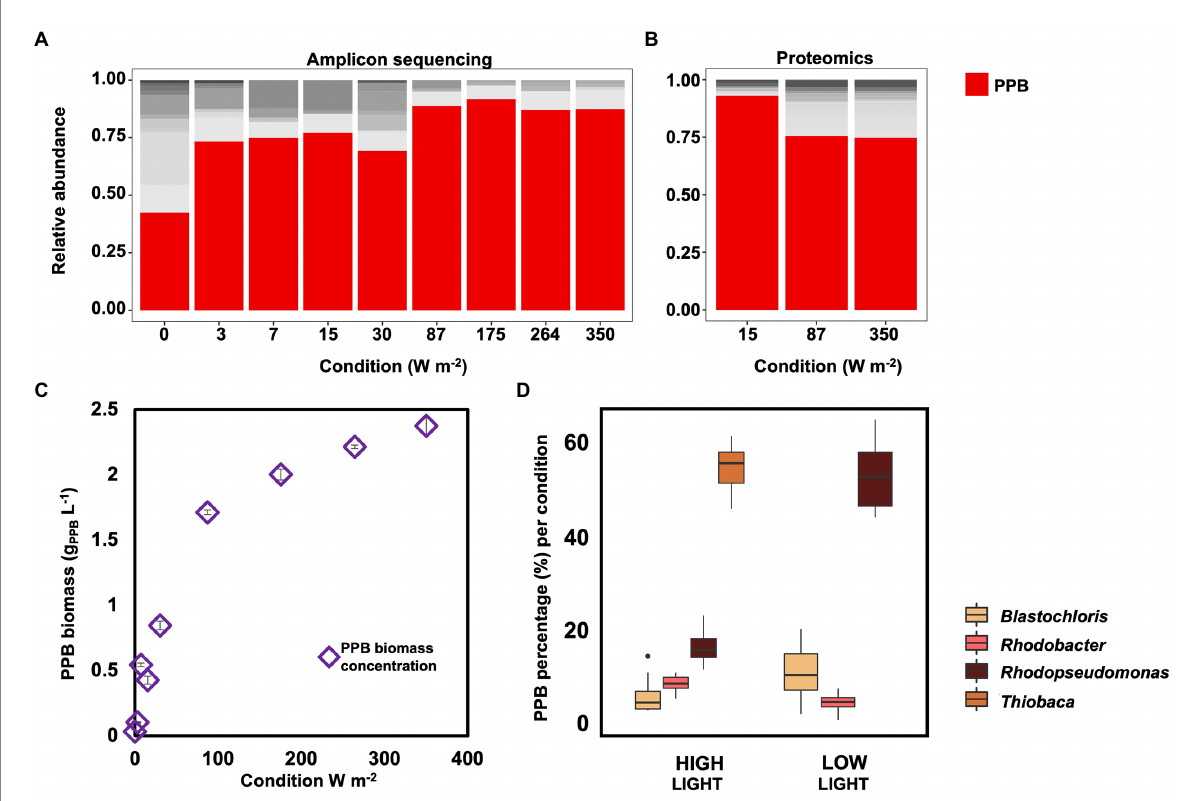
FIGURE 3 (A) Amplicon sequencing results for community composition. PPB genera (Blastochloris, Rhodobacter, Rhodopseudomonas and Thiobaca, red bars) were the dominant guild under all condition, accounting for ca 70% of the total community, excluding under dark condition. (B) Metaproteomic analysis of the community composition for selected samples. These results confirmed the amplicon sequencing results. (C) PPB concentration in the bulk liquid increased with the increase of incident light intensity. (D) Distribution of the main PPB genera based on amplicon sequencing results under high (350–87 W m − 2 ) and low (30–0 W m − 2 ) conditions. Notably, the genus Thiobaca was present only under high light